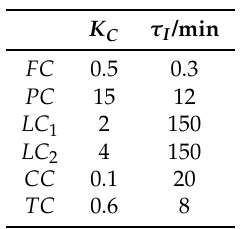
Table 3. Proportional gain and integral time constant of all the PI controllers in the distillation case study.